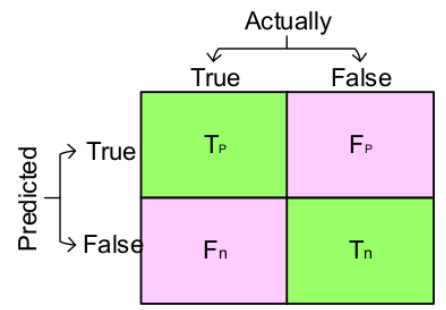
Figure 3. Confusion matrix.